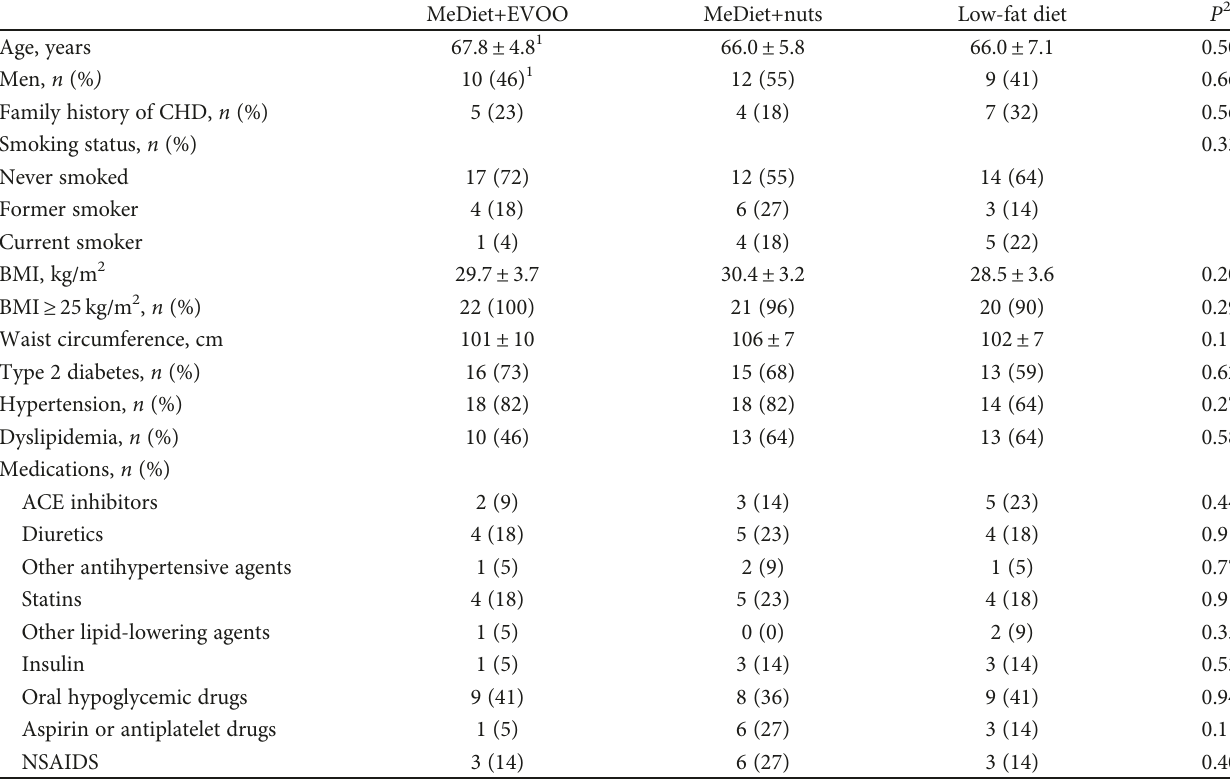
Table 1: Baseline characteristics of the participants at high risk for cardiovascular disease included in the study and classi fi ed according to the dietary intervention